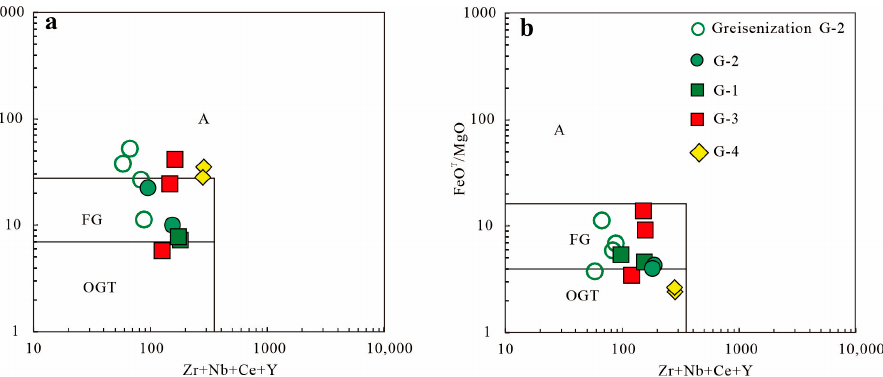
Figure 13. Genetic type discrimination diagram of intrusions in Chuankou ore field, ( a ) ALK versus Zr + Nb + Ce + Y diagram, ( b ) FeO T /MgO versus Zr + Nb + Ce + Y diagram (after